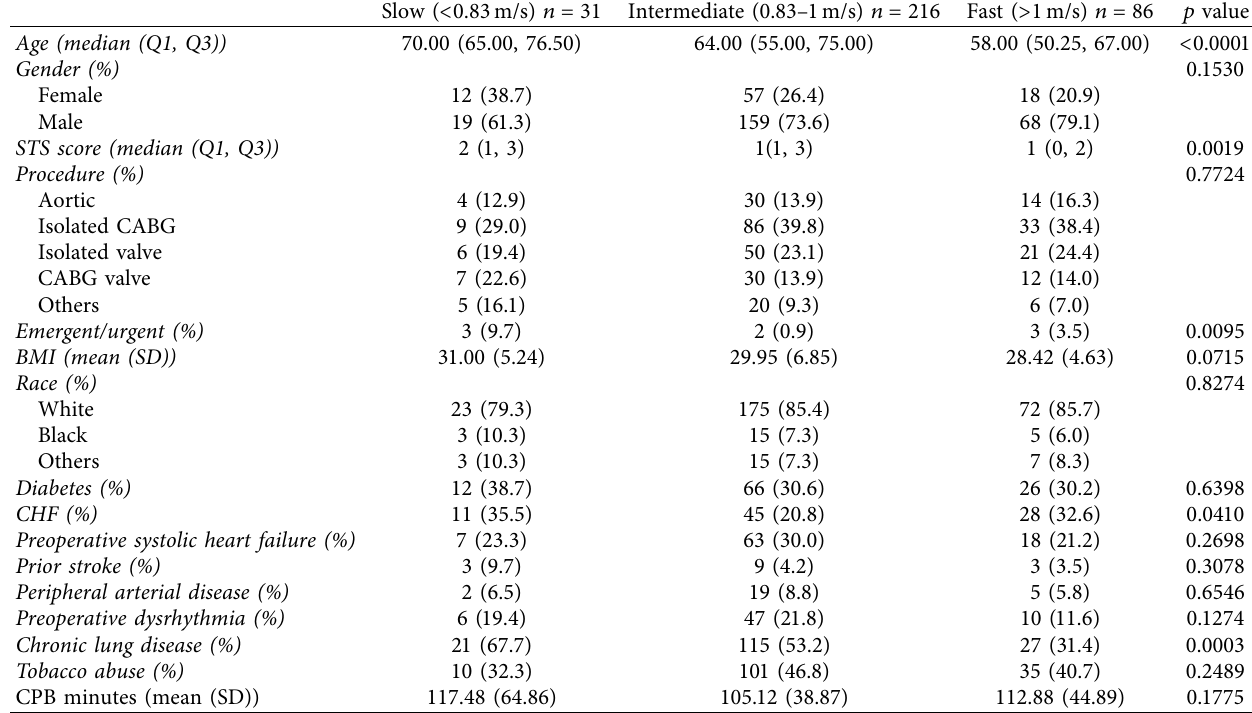
Table 1: Baseline characteristics for the study patients stratified into tertiles of gait speeds.